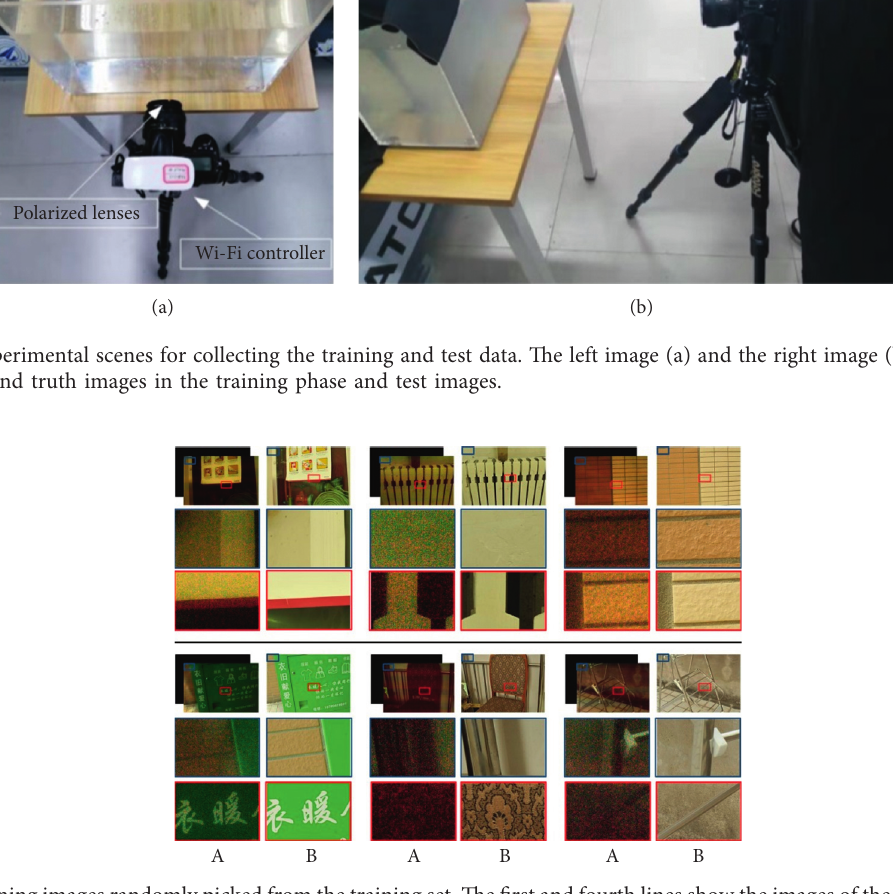
Figure 8: The training images randomly picked from the training set. The first and fourth lines show the images of the original size, and the subsequent two lines are the corresponding magnified images. The pictures of column A are the dark and fuzzy pictures taken in a low-light environment. Because the original pictures are dark and invisible, we used Ubuntu software for brightness adjustment. The pictures of column B are the corresponding clear images.